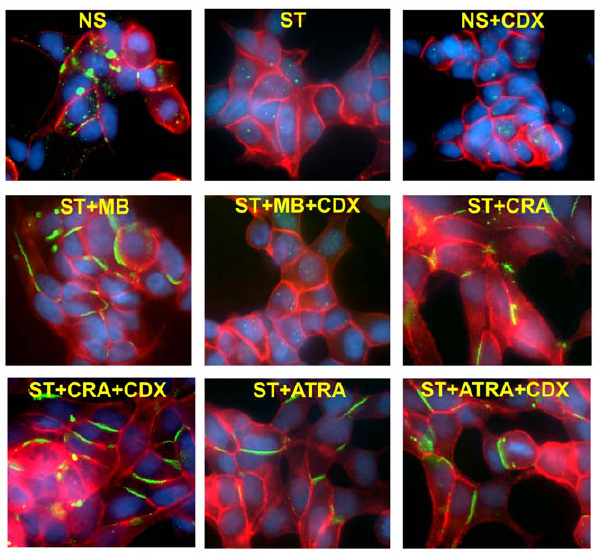
Figure 5. Effect of 9-CRA, ATRA, and androgens on the formation of gap junctions in the presence and the absence of casodex. LNCaP-32 cells, seeded in six well clusters containing glass cover slips, were allowed to grow to 70% confluence. Cells were then